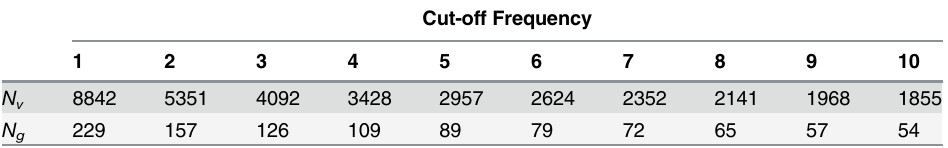
Table 4. Number of vocabulary words and number of glossary words for various cut-off frequencies. N v and N g are the number of vocabulary words from the book and number of glossary words for each cut-off frequency, respectively.